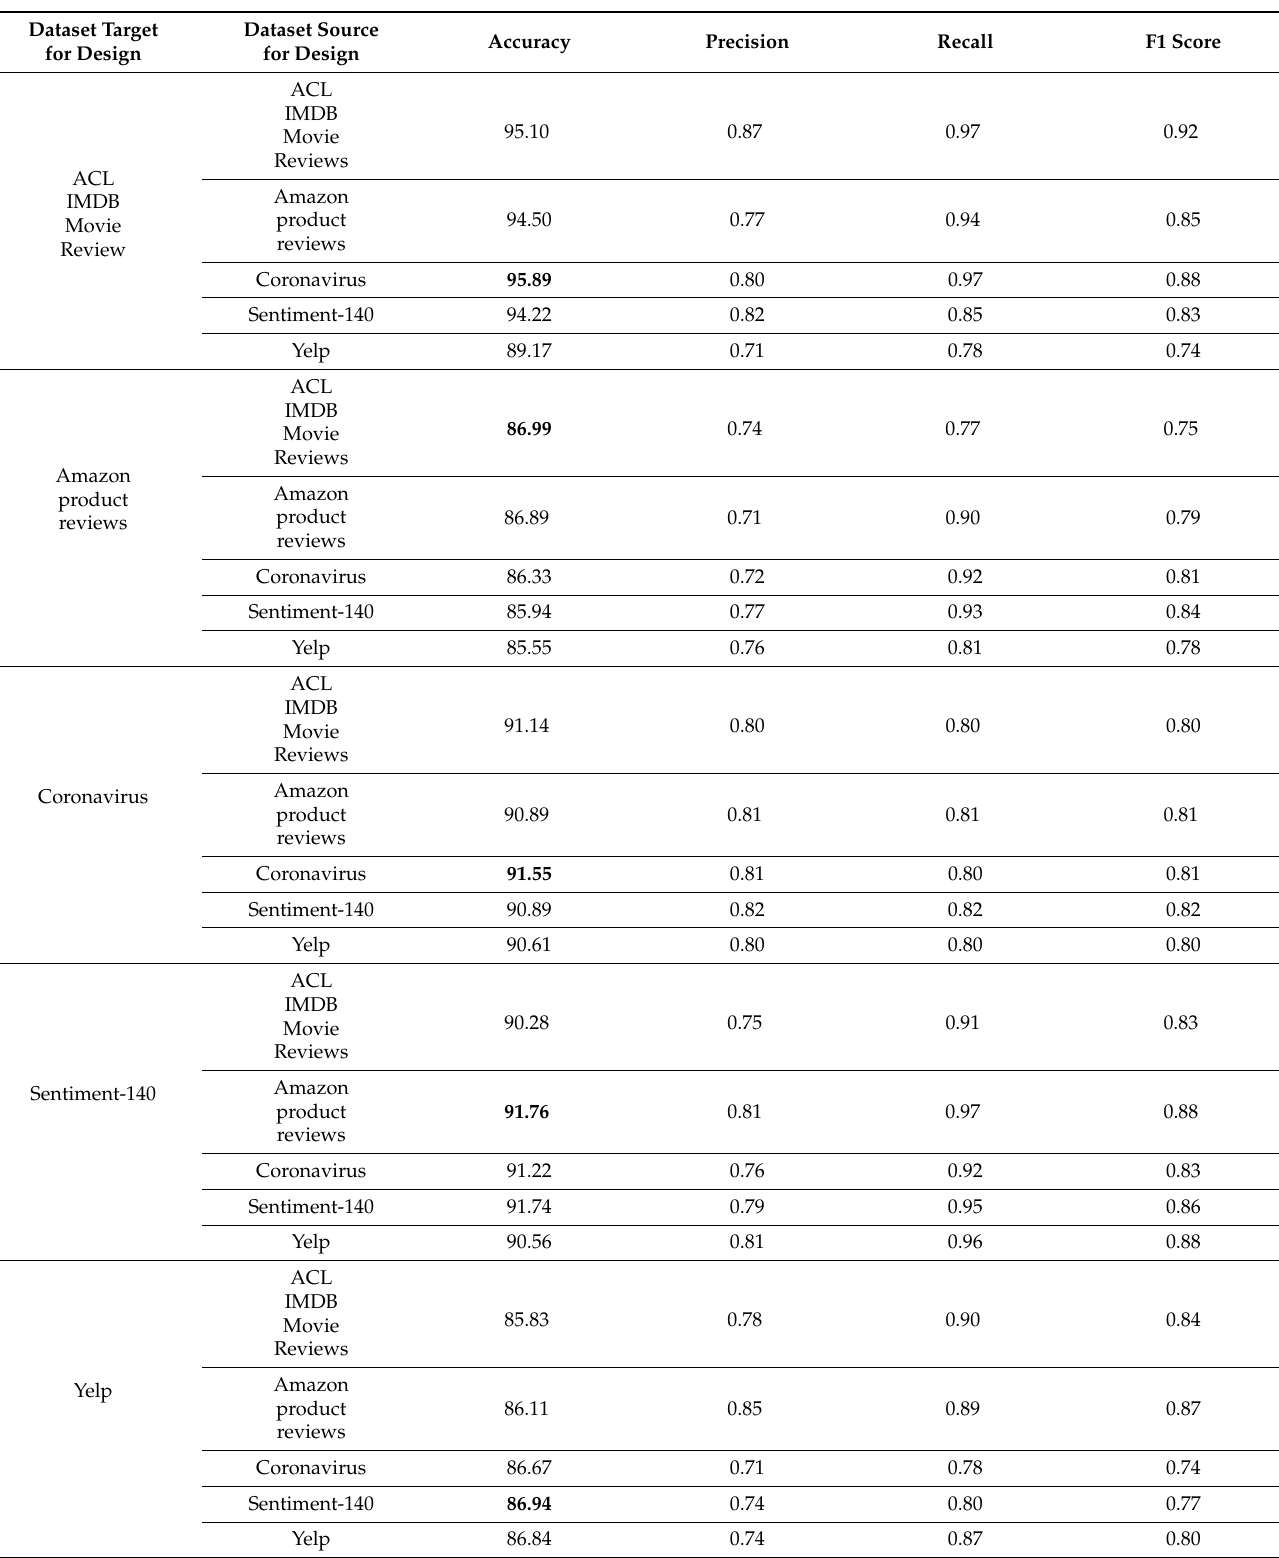
Table 12. Results of running the SPHH with transfer learning for the sentiment analysis